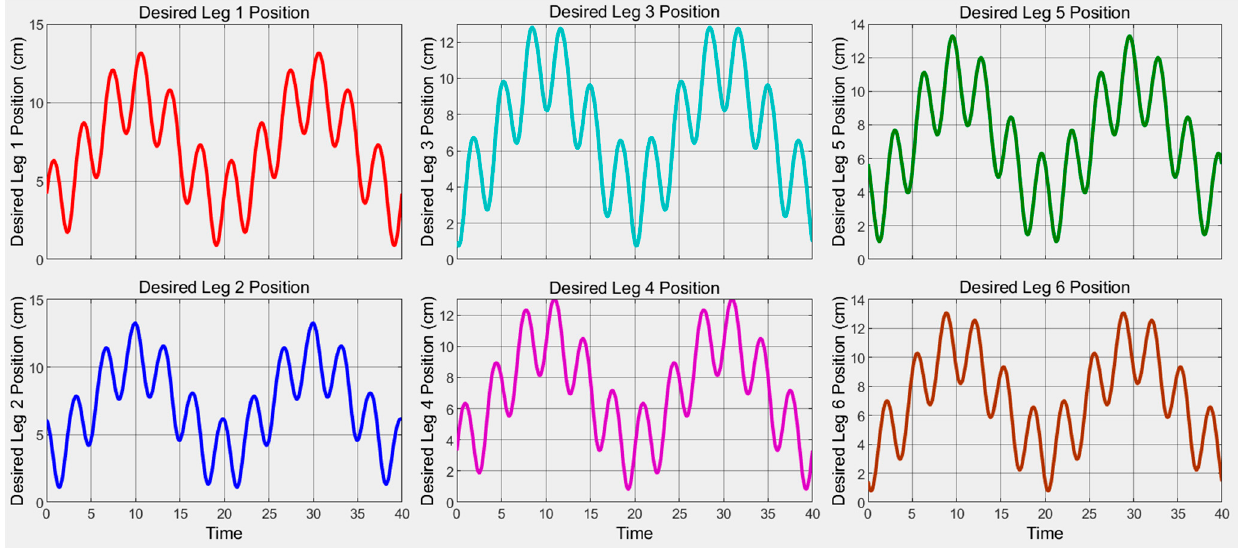
Figure 15. Desired leg position simulation results for reference trajectory.